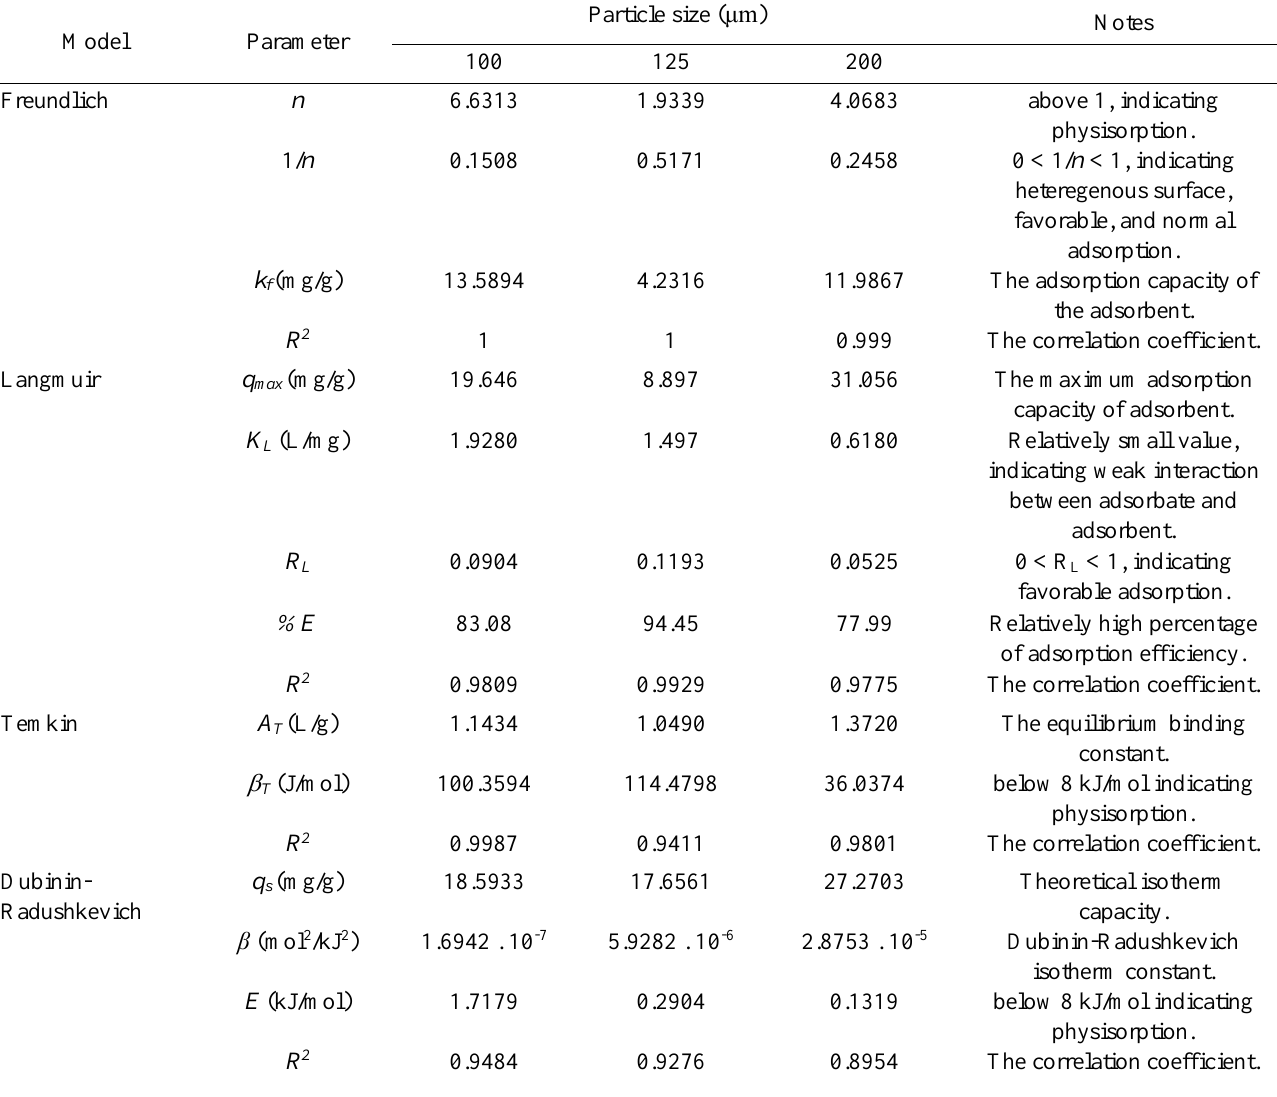
Table 1. Models of isotherm adsorption in this study